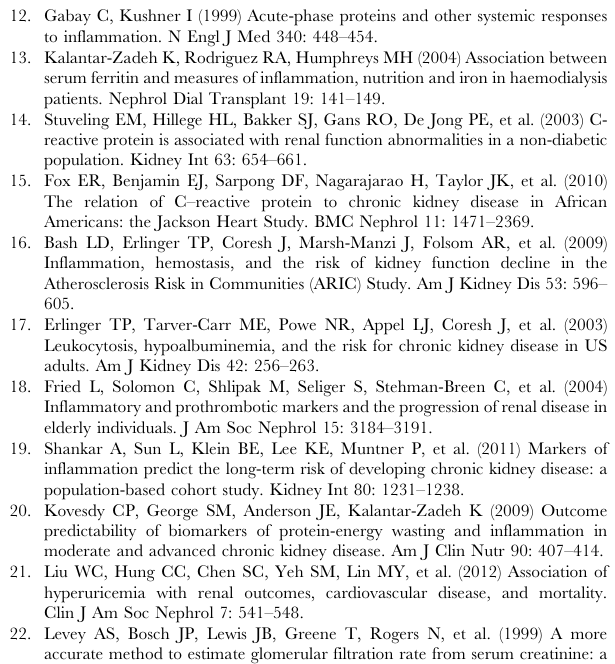
Table S1 Sensitivity analysis - Cox proportional haz- ards regression analysis of risks for renal replacement treatment according to different divisions of hsCRP. Table S2 Sensitivity analysis - Cox proportional haz- ards regression analysis of risks for renal replacement treatment according to different divisions of